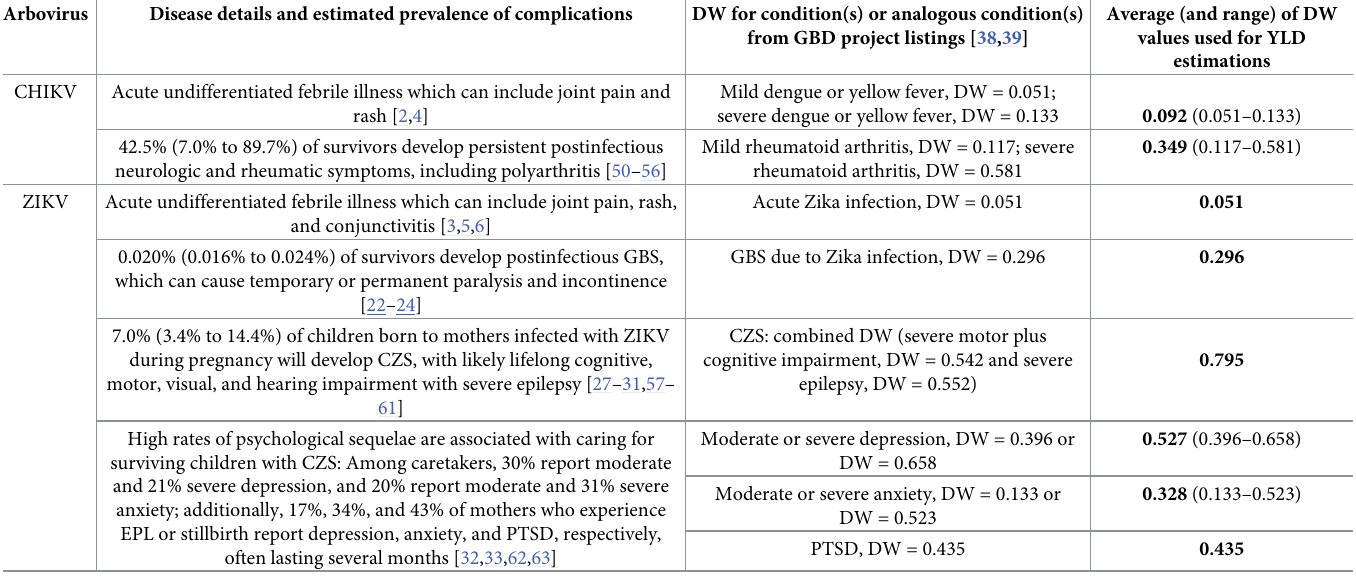
Table 1. Summarized symptom frequency and related DWs. Arbovirus Disease details and estimated prevalence of complications DW for condition(s) or analogous condition(s)